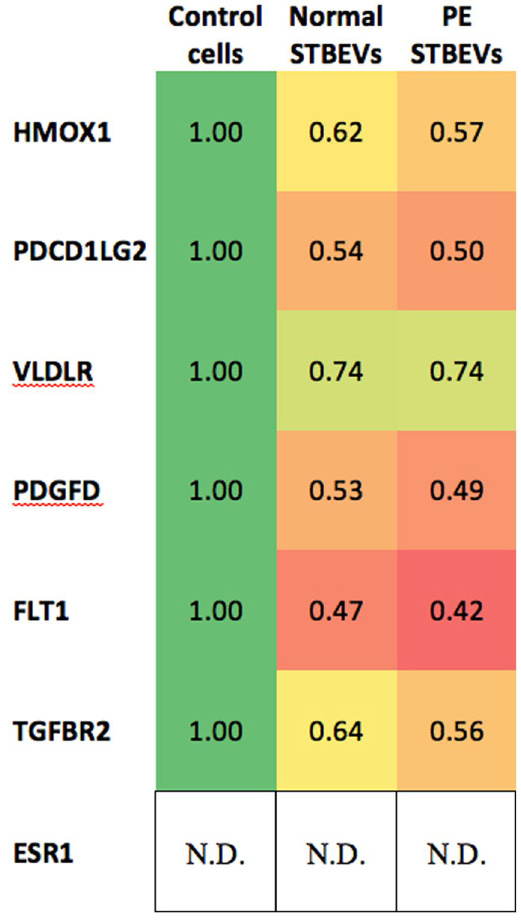
Figure 5. Target gene fold changes in HCAECs, after treatment with normal or PE STBEVs compared to controls. Heat-map showing fold change for each gene relative to control cells. A deviation from 1.0 indicates down-regulation of gene expression. N.D (not detected) in HCAEC